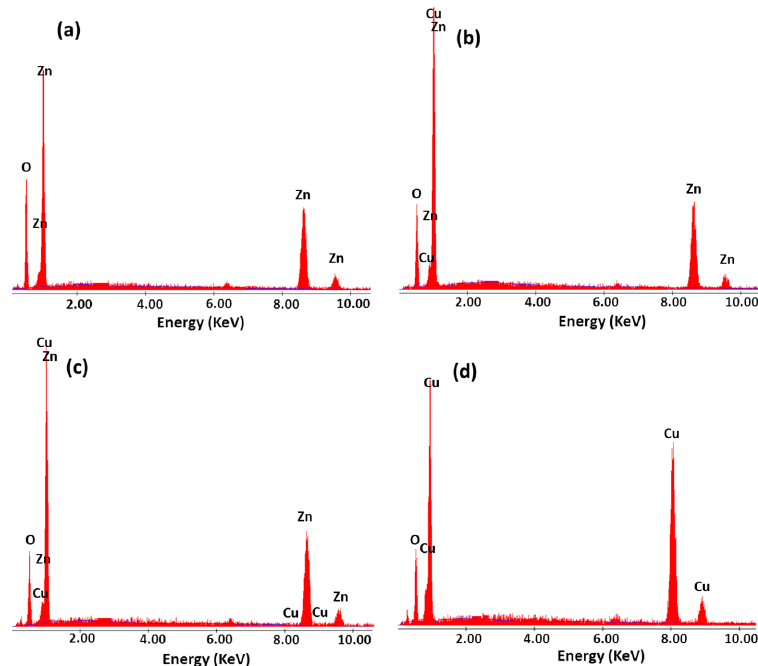
Figure 4. EDAX spectra of electrosynthesized composite thin films: ( a ) chitosan-ZnO; ( b ) chitosan-Zn 0.6 Cu 0.4 O; ( c ) chitosan-Zn 0.3 Cu 0.7 O; and ( d ) chitosan-CuO.